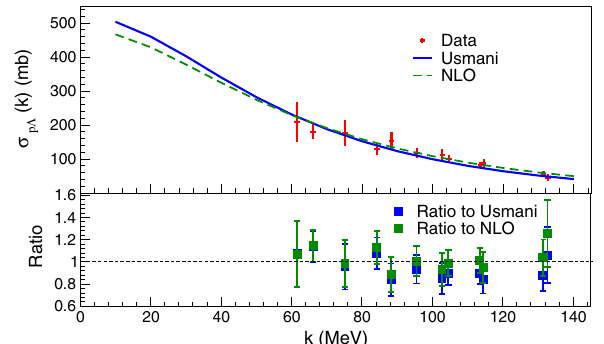
Fig. 3 Cross section for p– (cid:2) as a function of the relative momentum k evaluated in CATS using the Usmani (blue solid line) and NLO χ EFT (greendashedline)potentials.Experimentaldataaretakenfrom[48,49]